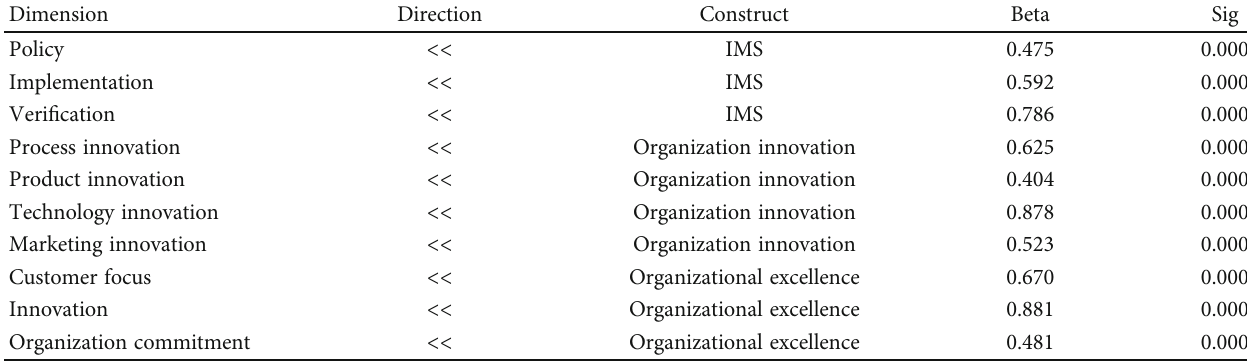
Table 10: Signi fi cance and strength of relationships between constructs and